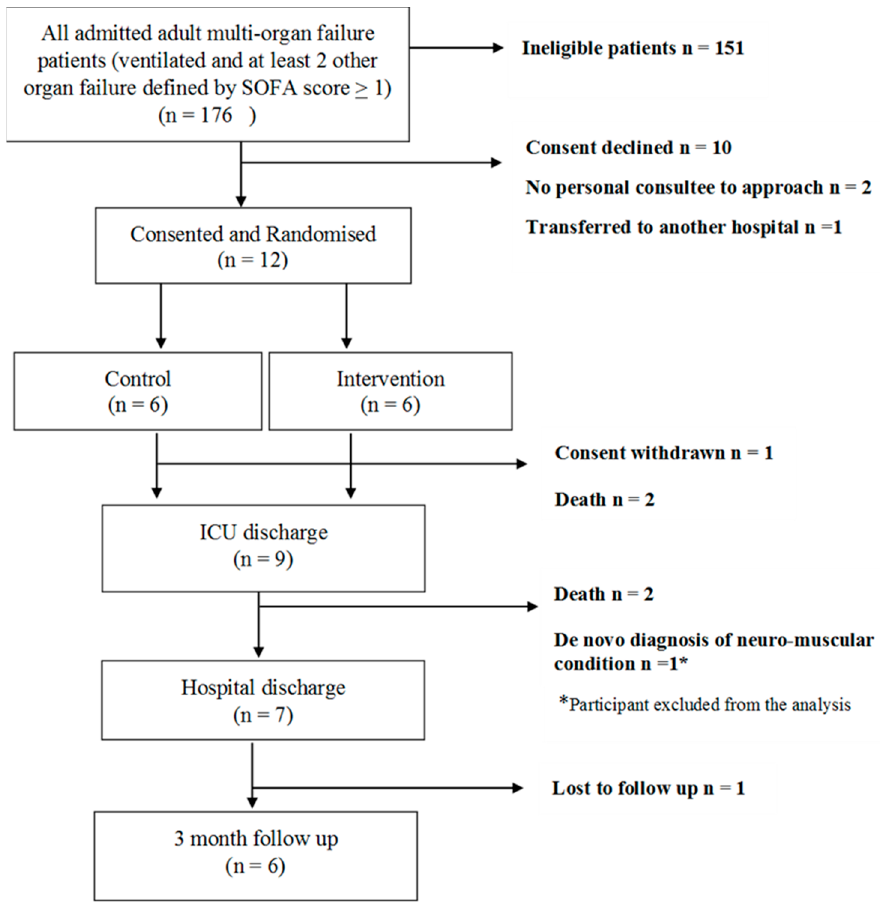
Figure 1. Study consort diagram. Table 1. Baseline characteristics of the control and intervention participants.